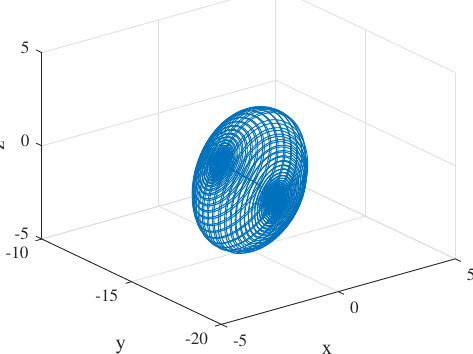
Figure 1. Phase diagrams with simulation time t = 2000 s for System (2).